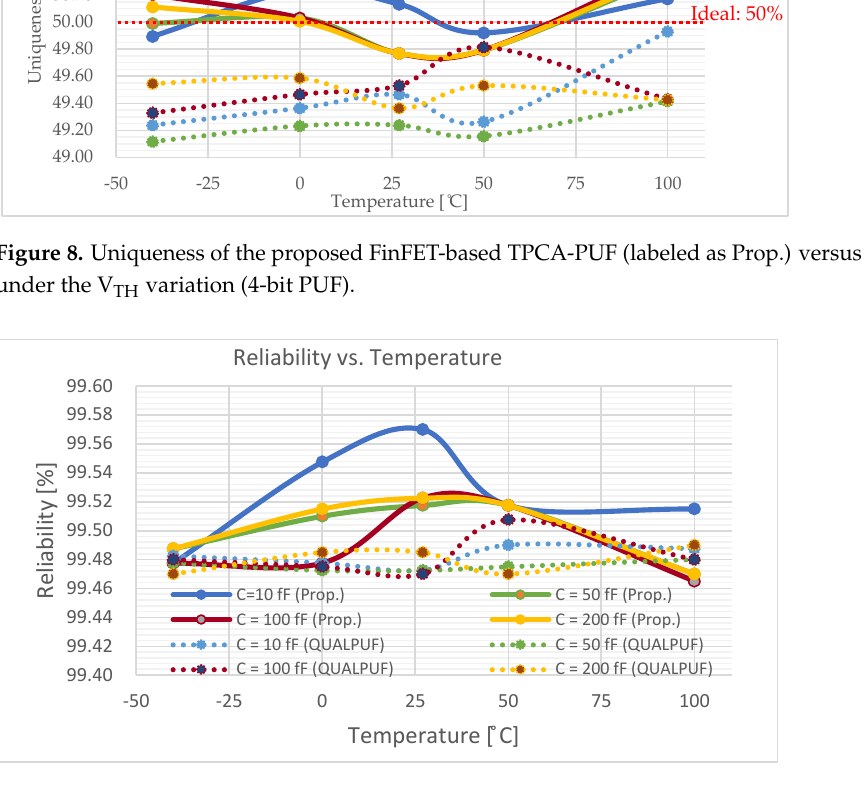
Figure 9. Reliability of the proposed FinFET-based TPCA-PUF (labeled as Prop.) versus QUALPUF under the V TH variation (4-bit PUF).